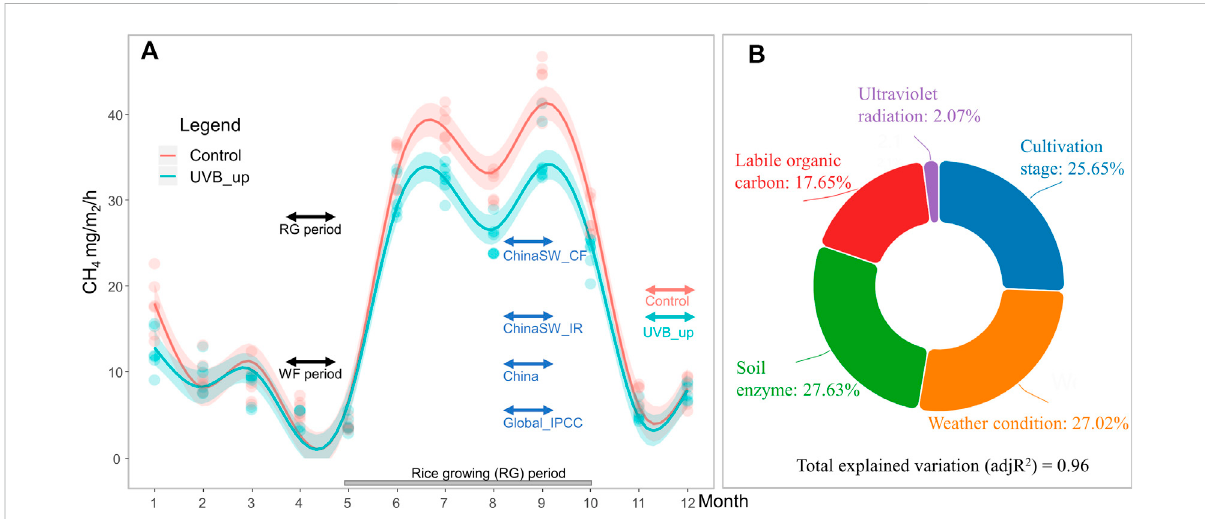
FIGURE 2 (A) Monthly dynamics of CH 4 emission under natural conditions (control, in red) and the in fl uence of enhanced UV-B radiation (UVB_up, in green) atYuanyang Terraces. Trends inCH 4 emissionswere described using ageneralized additive model (with95%con fi dence intervals given).The double-headedblackarrowsshowmeanCH 4 emissionsinthewinterfallowperiod(WFperiod)andtherice-growingperiod(RGperiod)inthisstudy. The double-headed blue arrows show mean CH 4 emissions in a continuously fl ooded paddy fi eld in southwest China (ChinaSW_CF) and in an intermittently irrigated paddy fi eld in southwest China (ChinaSW_IR), the mean value of CH 4 emissions over the whole of China (China) (Yan et al., 2003),and theglobal CH 4 baselineemission factor (Global_IPCC)(Rahman and Yamamoto 2020b). (B) Relative contribution (%) ofeachexplanatory